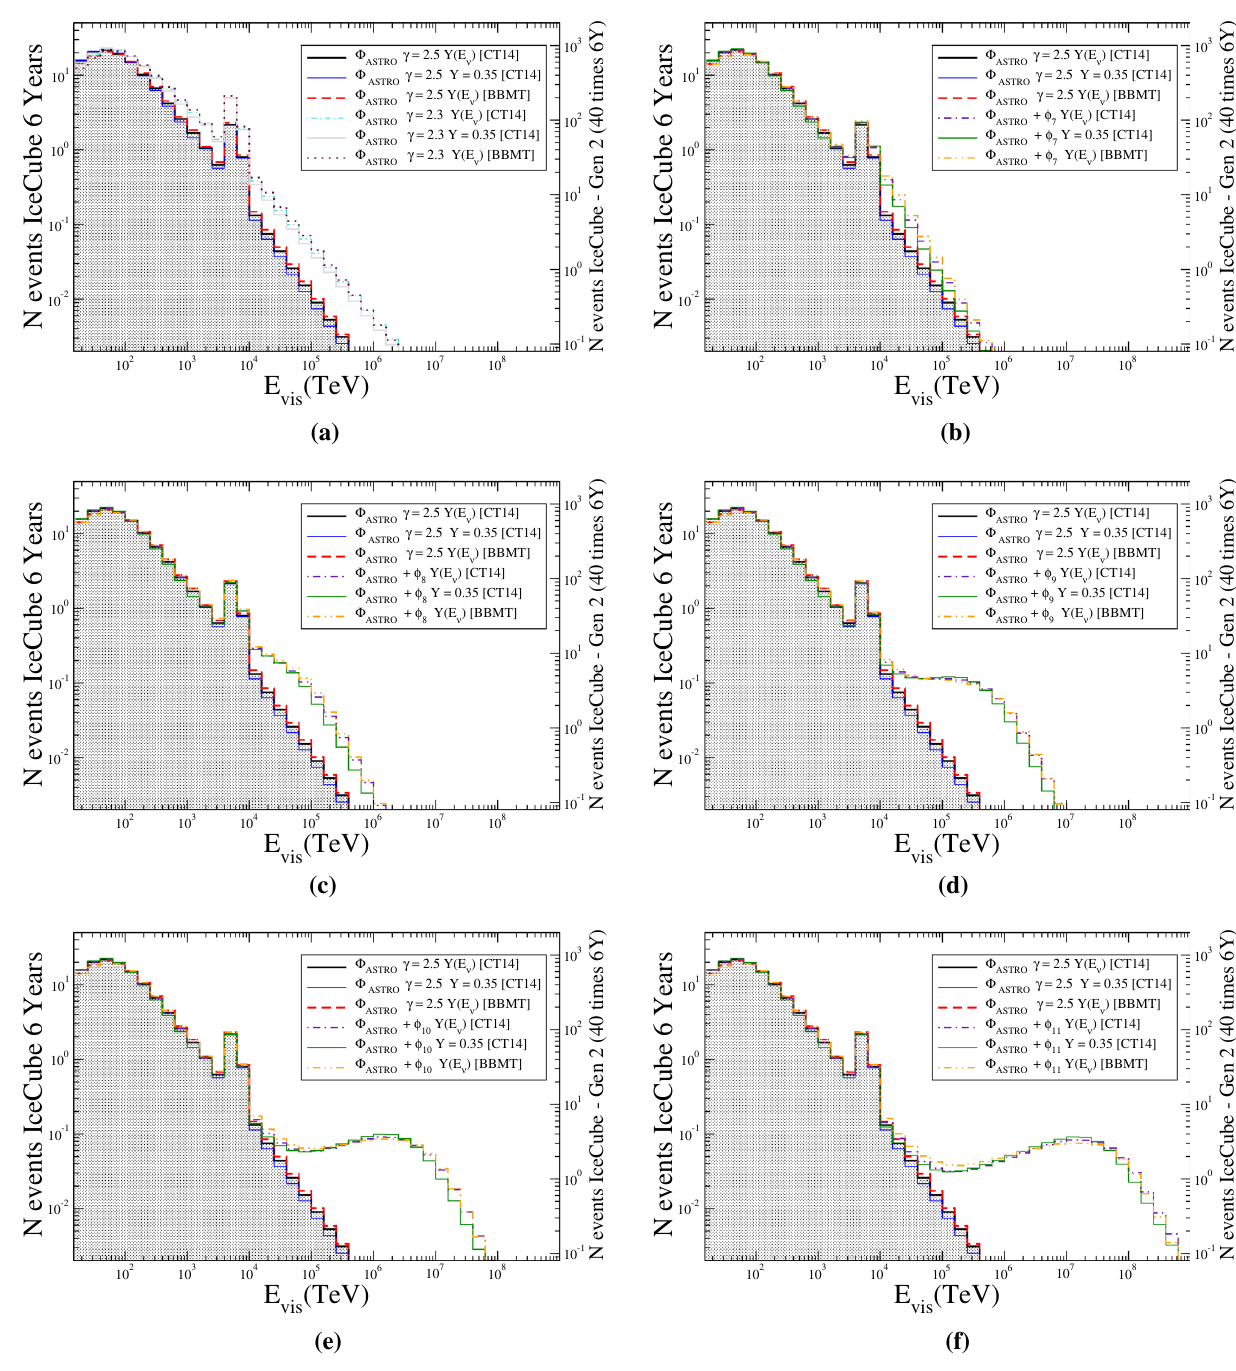
Fig. 9 Number of events in the IceCube detector as function of the visible energy for the distinct QCD models and fluxes considered. The left vertical axis refers to 6 years the detector exposure, while in the right vertical axis represent the number of expected neutrino events is rescaled to the exposure of the IceCube-Gen2. The standard astrophys-